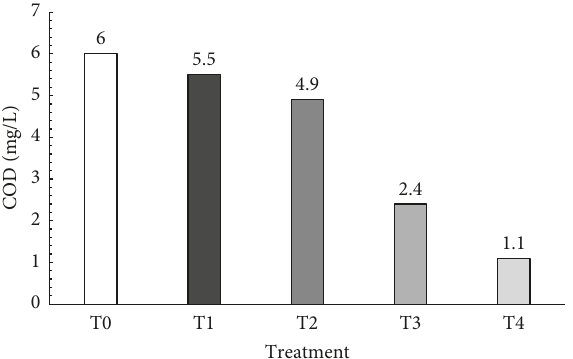
Figure 4: COD of diethyl (3H-1-ethoxy-3-phenoxazinylidene) ammonium chloride solution samples as a function of treatment. T0 is the diethyl (3H-1-ethoxy-3-phenoxazinylidene) ammonium chloride solution sample without treatment.